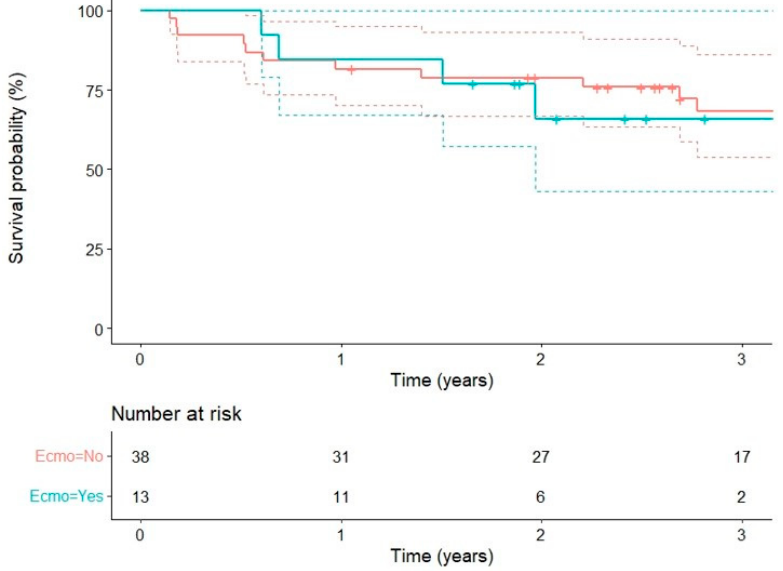
Figure 2. Kaplan–Meier survival curves (solid lines) and 95% confidence interval (dashed lines) for ECMO and non-ECMO patients. Table 1. Study population: descriptive statistics. Continuous data are reported as medians (I, III